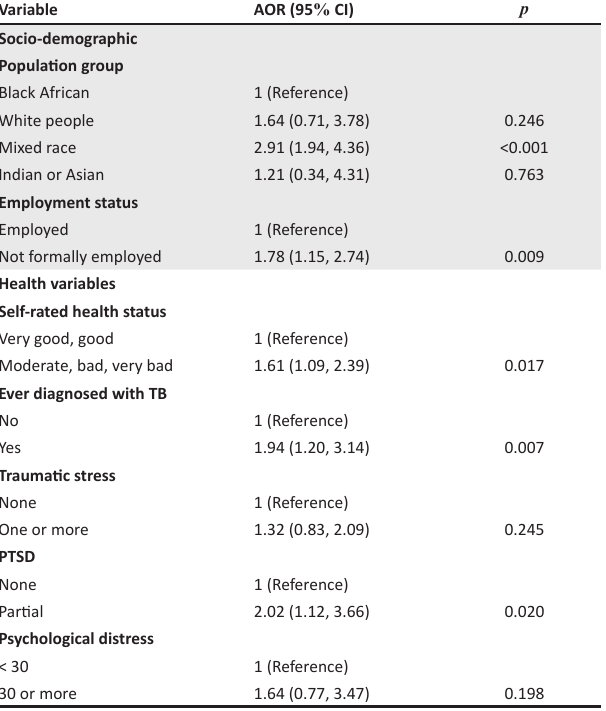
TABLE 2: Multivariable logistic regression on alcohol use during pregnancy.